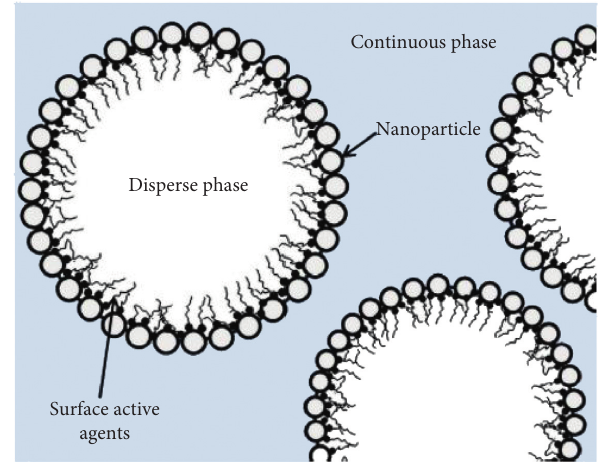
Figure 3: Diagrammatic sketch of three-phase-foams after foaming